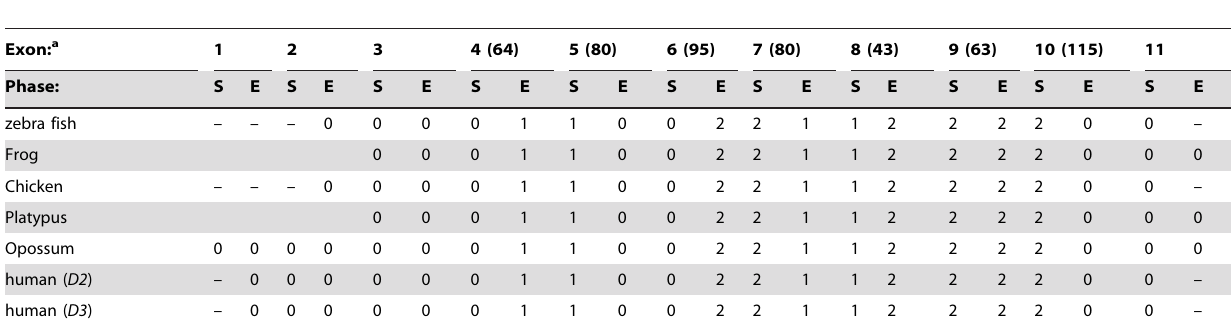
Table 1. Phases at exons in the MAGE coding sequence of zebrafish, African clawed frog, chicken and mammals.